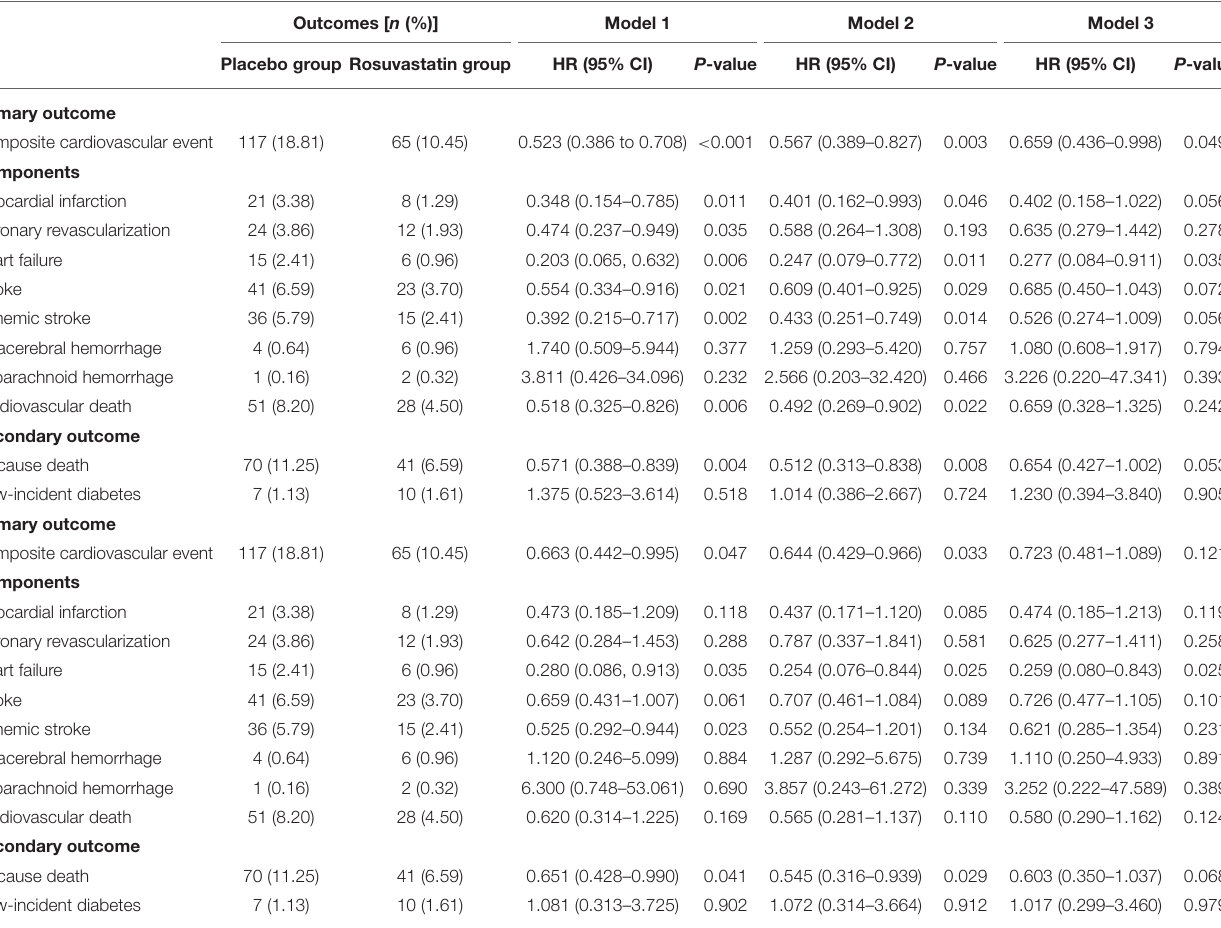
TABLE 3 | Cumulative hazards of outcomes in the rossuvastatin group compared with the placebo group. Outcomes [ n